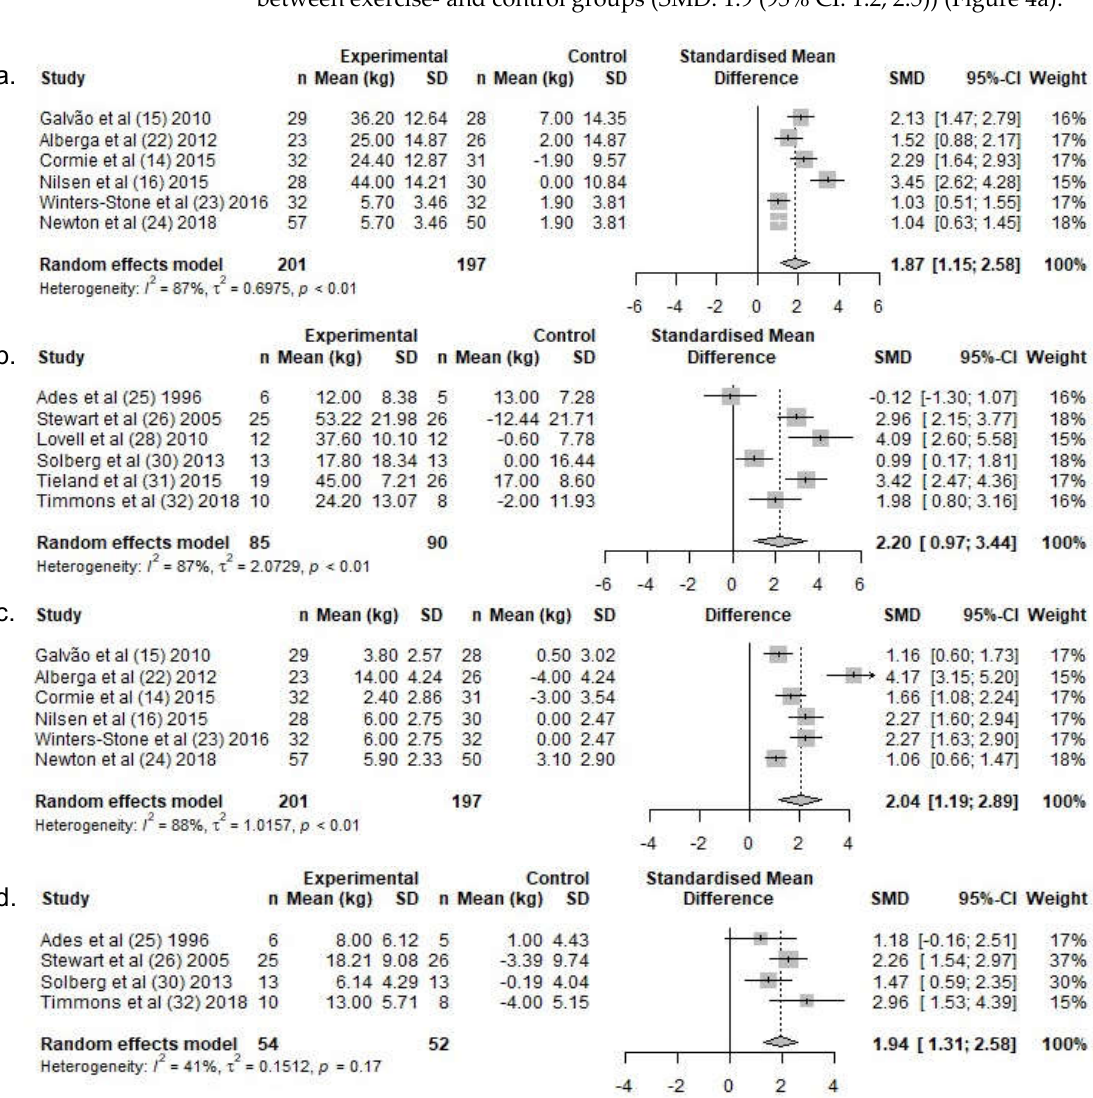
Figure 4. Meta-analysis for change in muscle strength for lower-body exercises for ( a. ) PCa and ( b. ) HEM, and in upper-body exercises for ( c. ) PCa and ( d. ) HEM. Abbreviations: n , Number; SD, stand- ard deviation; SMD, standardized mean difference; CI, confidence